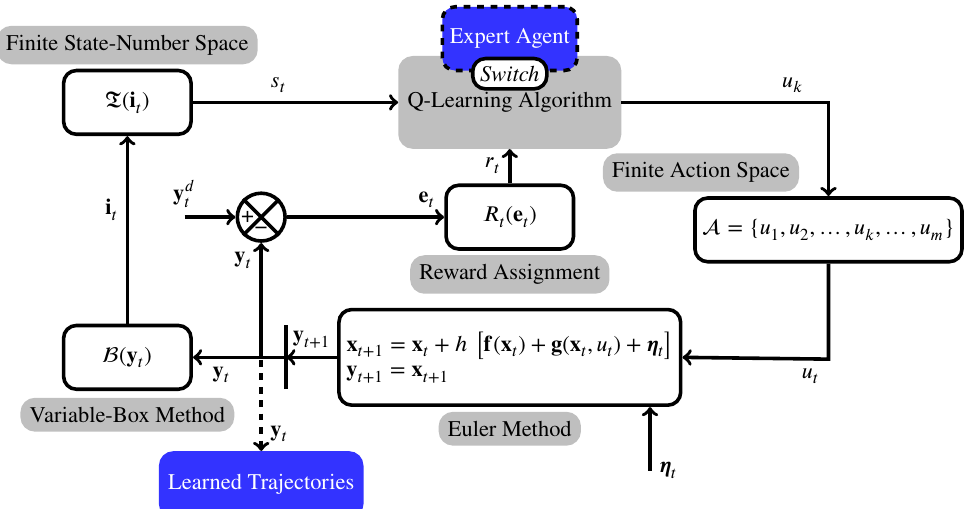
Figure 3. Schematic diagram of the proposed variable box method with Q-learning. Two feedback loops reinforce the intertwined closed-loop dynamic interplay of the expert agent to guarantee y t → y d , whereas the cumulative reward r t is t